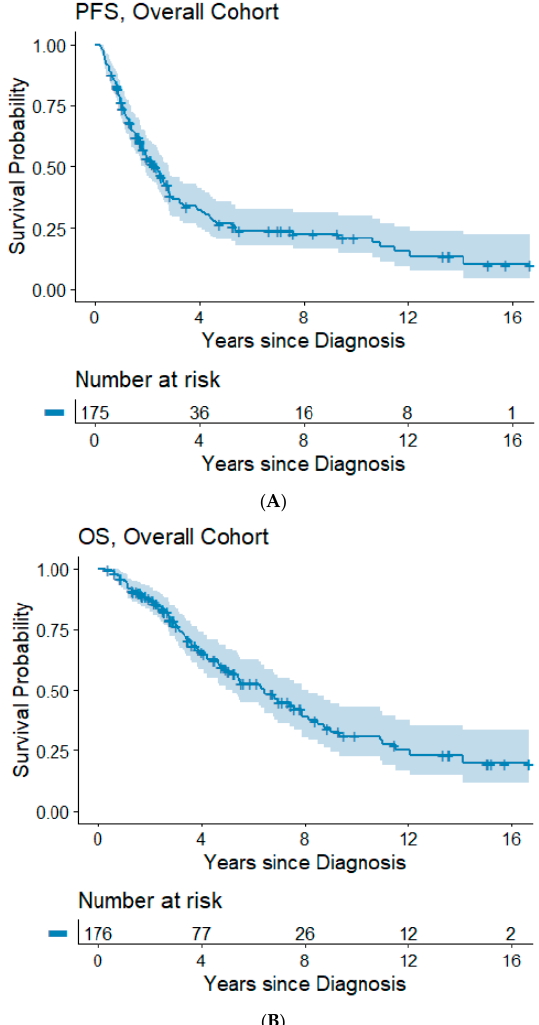
Figure 1. ( A , B ) Progression-free and overall survival of the overall cohort. Abbreviations: OS, overall survival; PFS, progression-free survival.